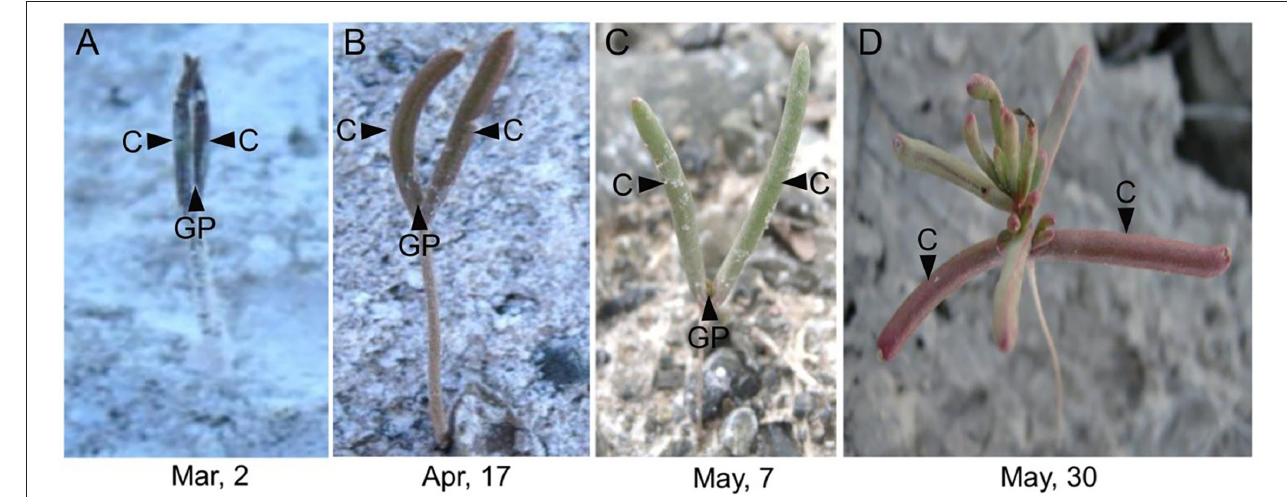
FIGURE 1 | Unique phenotype of “big cotyledons” of Suaeda aralocaspica in the natural habitat. C, cotyledon; GP, growth point; Mar, March; Apr, April. (A) Early-stage germinating seedling, (B) one-month-old seedling, (C) 2-month-old seedling, and (D) 3-month-old seedling.